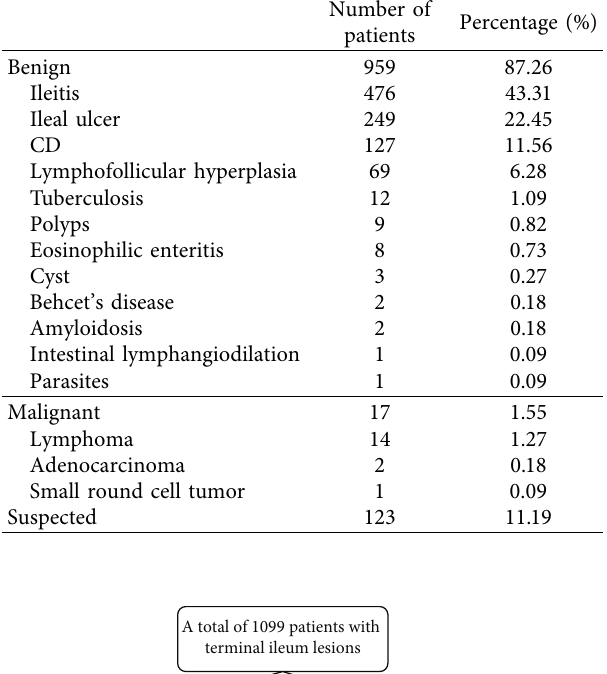
Table 3: Disease spectra of patients with terminal ileum lesion.